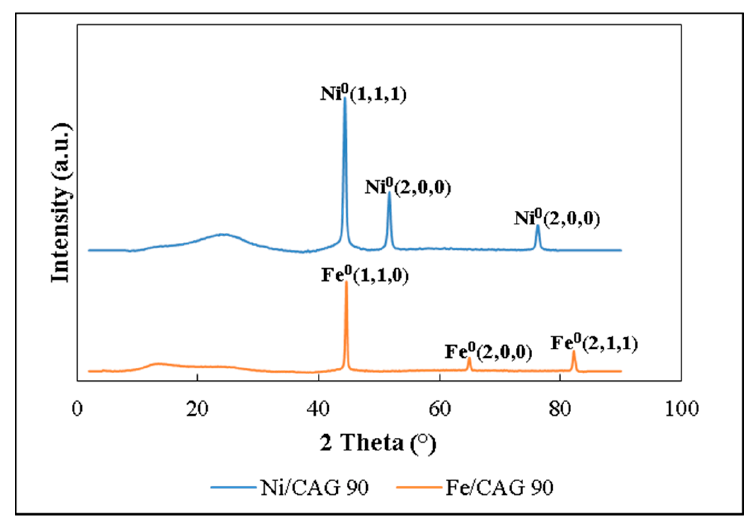
Figure 7. XRD patterns of Ni/CAG 90 and Fe/CAG 90 catalysts. Table 7. XRD crystallite size (Equation (1)) for selected Ni and Fe crystal planes in both catalysts.